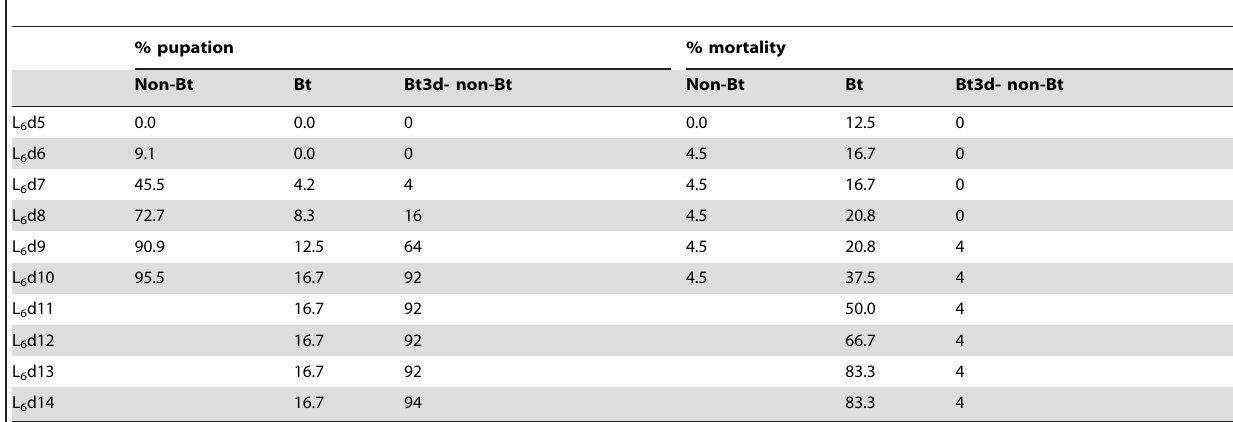
Table 2. Accumulated pupation (%) and mortality (%) of Helicoverpa armigera larvae fed on the non-Bt and Bt diet during the whole last larval instar or for three days with the Bt diet and then with the non-Bt diet during the rest of the instar (Bt3d-nonBt).